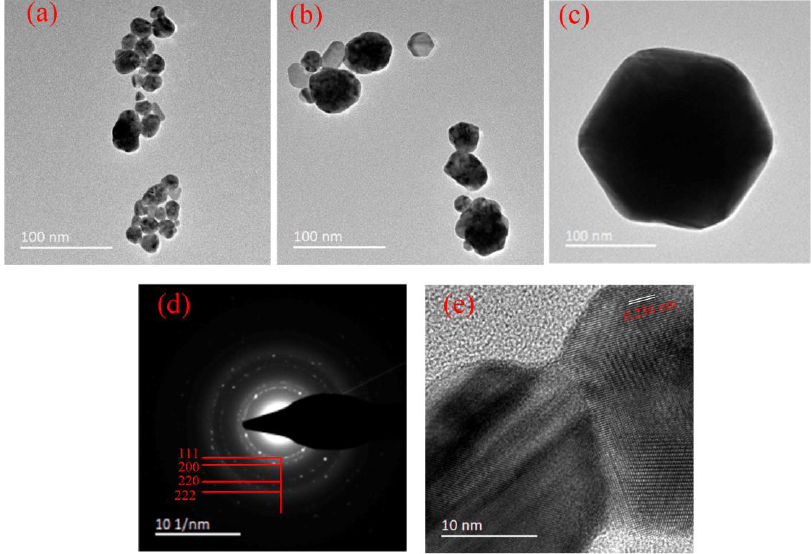
Figure 6. TEM images with different HAuCl 4 /sodium citrate ratios: ( a ) 1:3, ( b ) 1:1.75, and ( c ) 1:0.3. ( d ) Selected area electron diffraction (SAED) pattern of an ensemble of AuNP, and ( e ) image of a typical single crystal of AuNP.